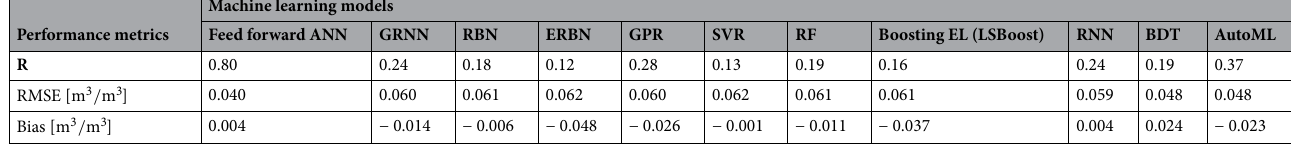
Table 3. Comparison with the benchmark algorithms (GRNN, RBN, Exact RBN, GPR, SVR, RF, Boosting EL, RNN, and BDT ) and AutoML